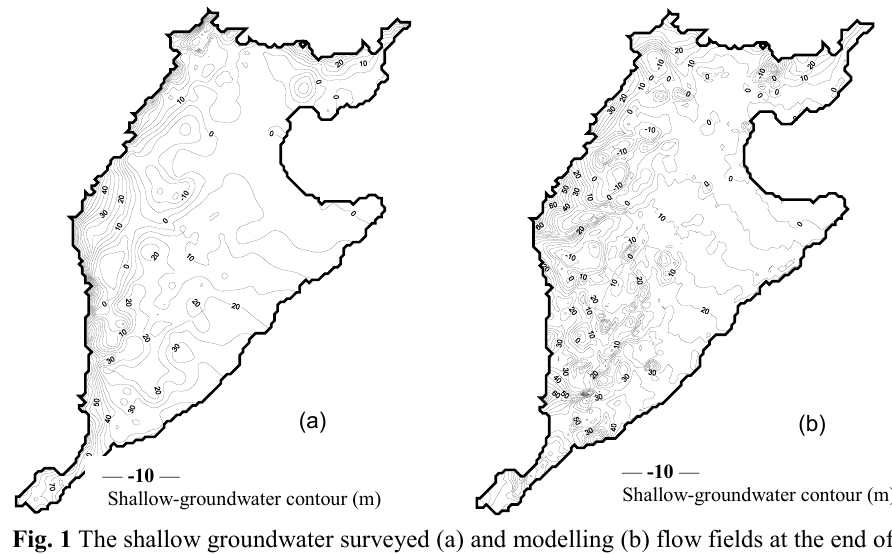
Fig. 1 The shallow groundwater surveyed (a) and modelling (b) flow fields at the end of validation.